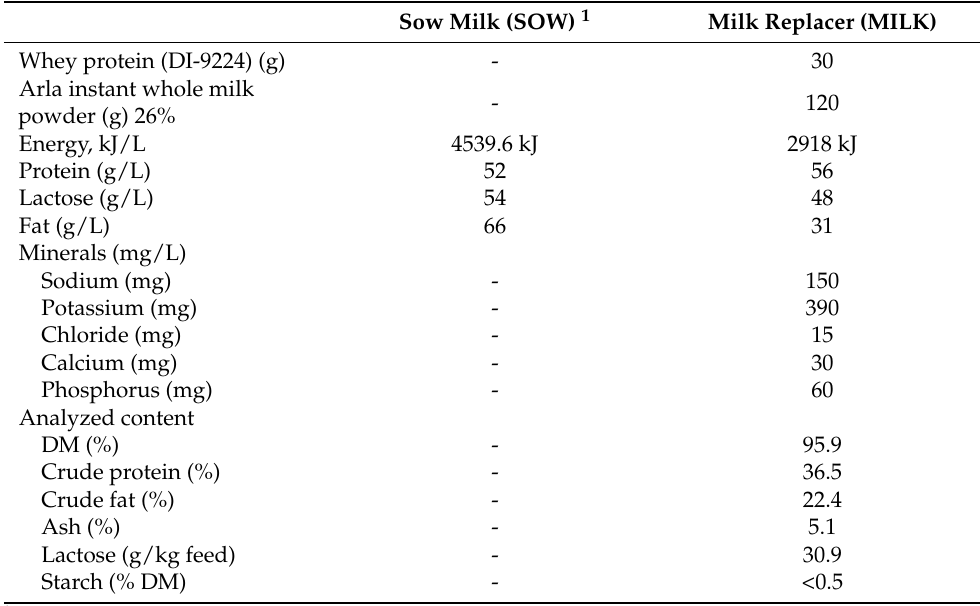
Table 1. Nutrient composition of the milk replacer (MILK) compared to a standard sow milk composi- tion (SOW) and analyzed chemical composition (as is) in the MILK group. Sow Milk (SOW) 1 Milk Replacer